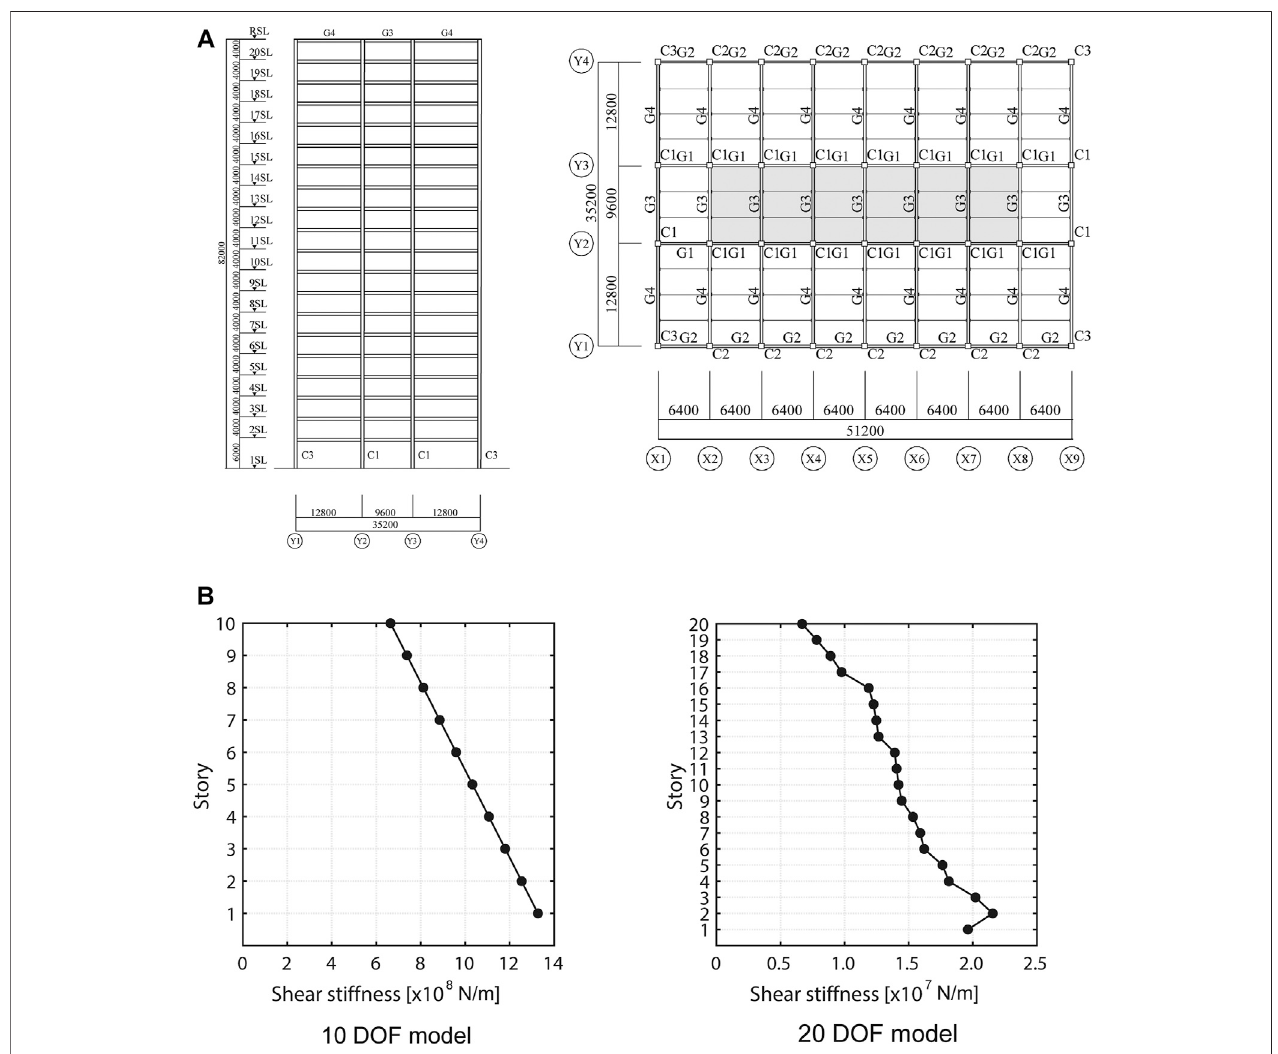
FIGURE7| Examplebuildingframe, (A) Planandelevationof20-storybuildingframe, (B) Storyshearstiffnessdistributionsof10DOFand20DOFbuildingmodels.